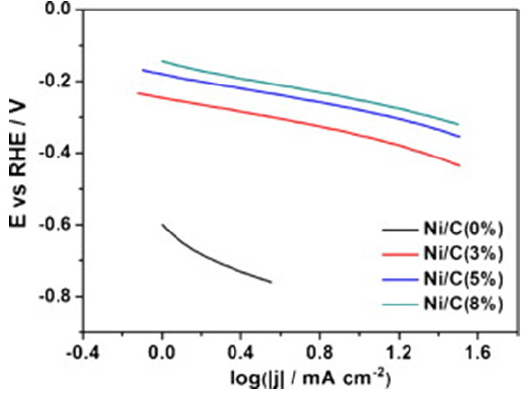
Figure 12. Tafel plots for Ni-decorated carbon nanofibers [233].